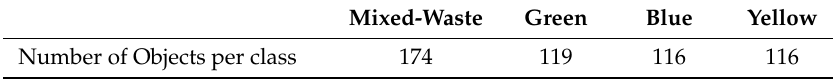
Table 3. The distribution of class instances in the training set.